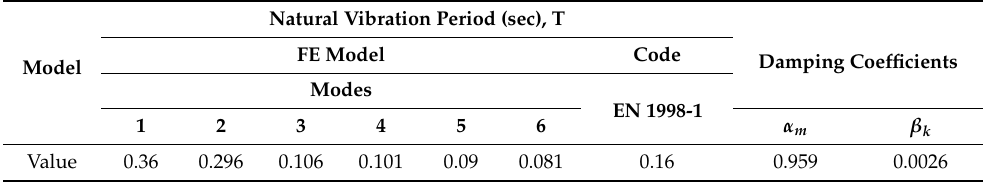
Table 1. First six natural vibration periods and factors of Rayleigh damping.